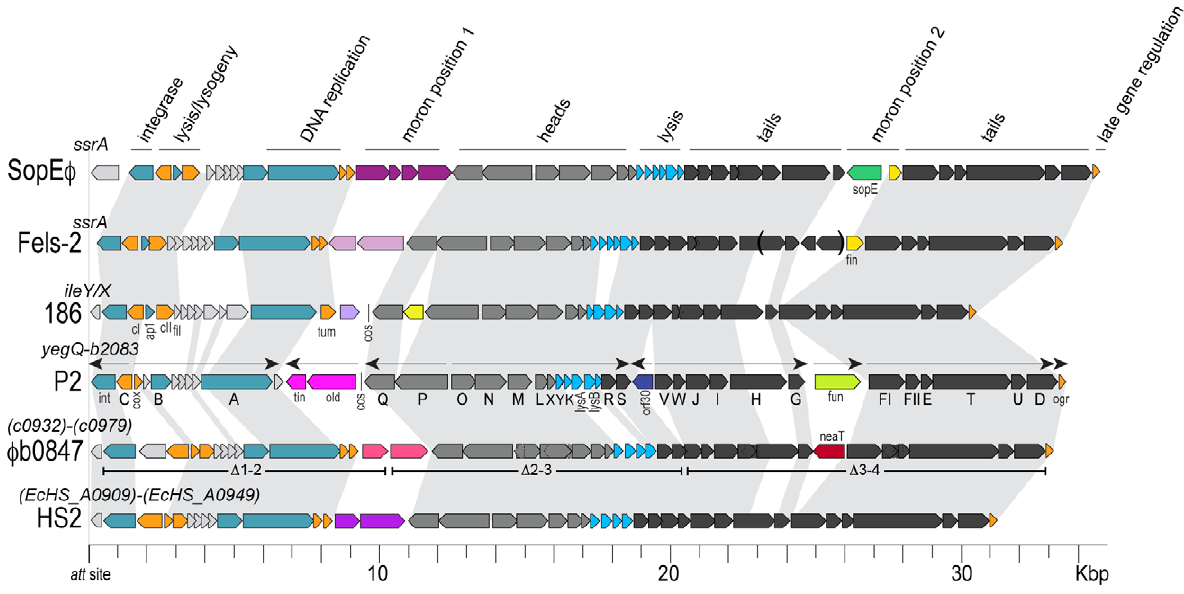
Figure 2. Alignment of w b0847 genome to other P2-like bacteriophage. Related P2-like prophages are aligned relative to their respective integration sites (att). Size is measured in kilobase pairs (Kbp). E. coli phages P2 and 186 and Salmonella phages Fels-2 and SopE5 were previously characterized. HS2 is an uncharacterized prophage contained within the genome of the commensal E. coli strain HS. Our unpublished analysis indicates that P2, 186, and Fels-2 represent three different ‘‘sequence types’’ based on virion proteins, which are typically . 85% identical within each of these three groups and 50–70% identical between the groups. Bracketed numbers below w b0847 indicate positions of the deletion mutants generated to assess the functionality of genes within broad regions of w b0847. The neaT gene is distinguished by a red open reading frame in moron position 2.